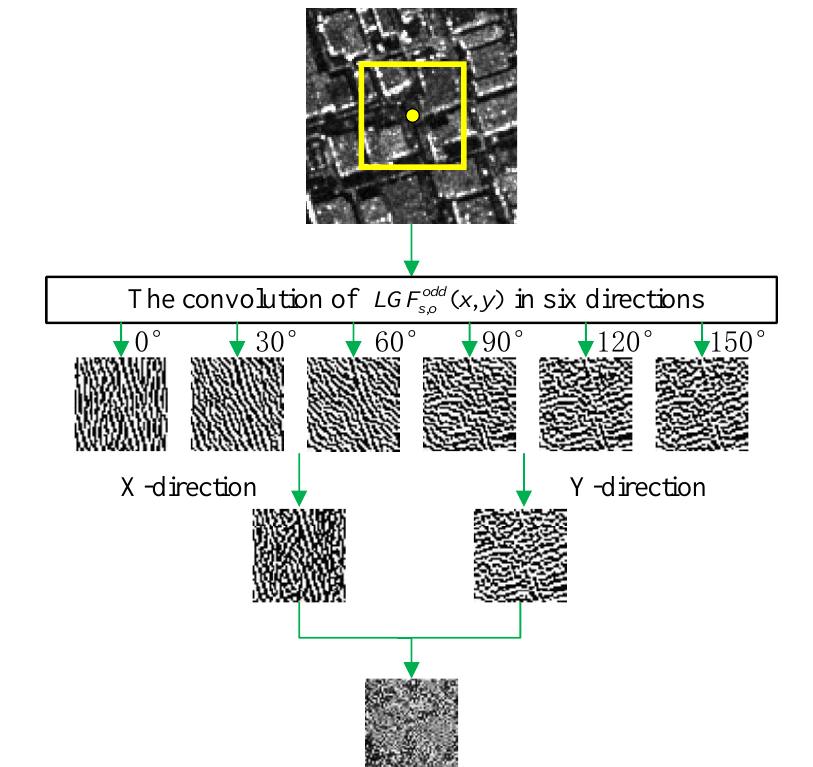
Figure 4. Multi-scale PCOs.